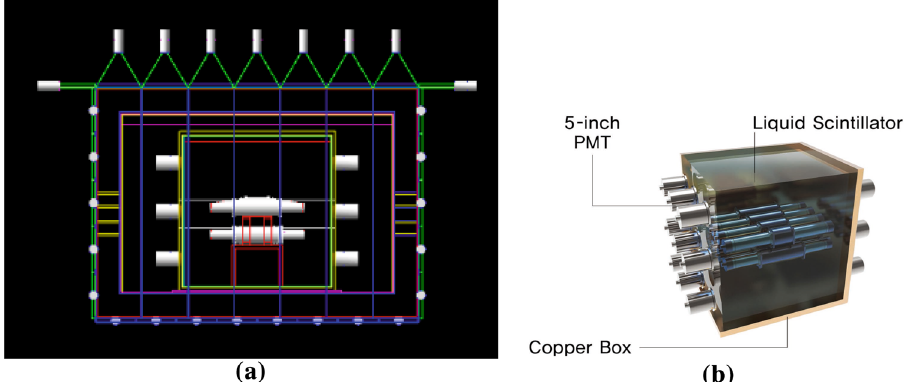
Fig. 1 Detector geometry (front view) used in the Geant4 simulation. a Two white-colored cylindrical shapes inside the center box represent the NaI(Tl) detectors supported by the acrylic frame (red) inside the LS. b Eighteen 5-inch PMTs are attached to two sides of the copper box to detect LS-produced